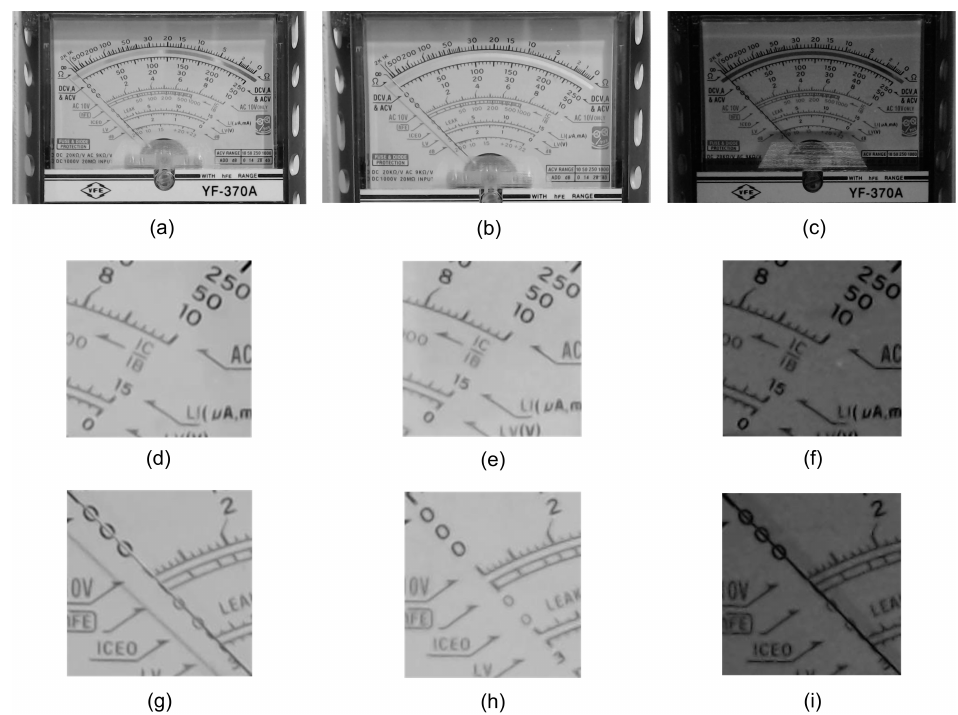
Figure 7. ( a ) The template ( T EGM ) used in the EGM method and ( b ) the bright template ( T PGM ) and IM bright-IM ( c ) the dark template ( T PGM ) used in the PGM method to locate R IM . ( d ) The template ( T EGM ) used dark-IM right-end in the EGM method and ( e ) the bright template ( T PGM ) and ( f ) the dark template ( T PGM ) bright-right-end dark-right-end used in the PGM method to locate R right-end . ( g ) The template ( T EGM ) used in the EGM method and left-end ( h ) the bright template ( T PGM ) and ( i ) dark template ( T PGM ) used in the PGM method to bright-left-end dark-left-end locate R left-end .